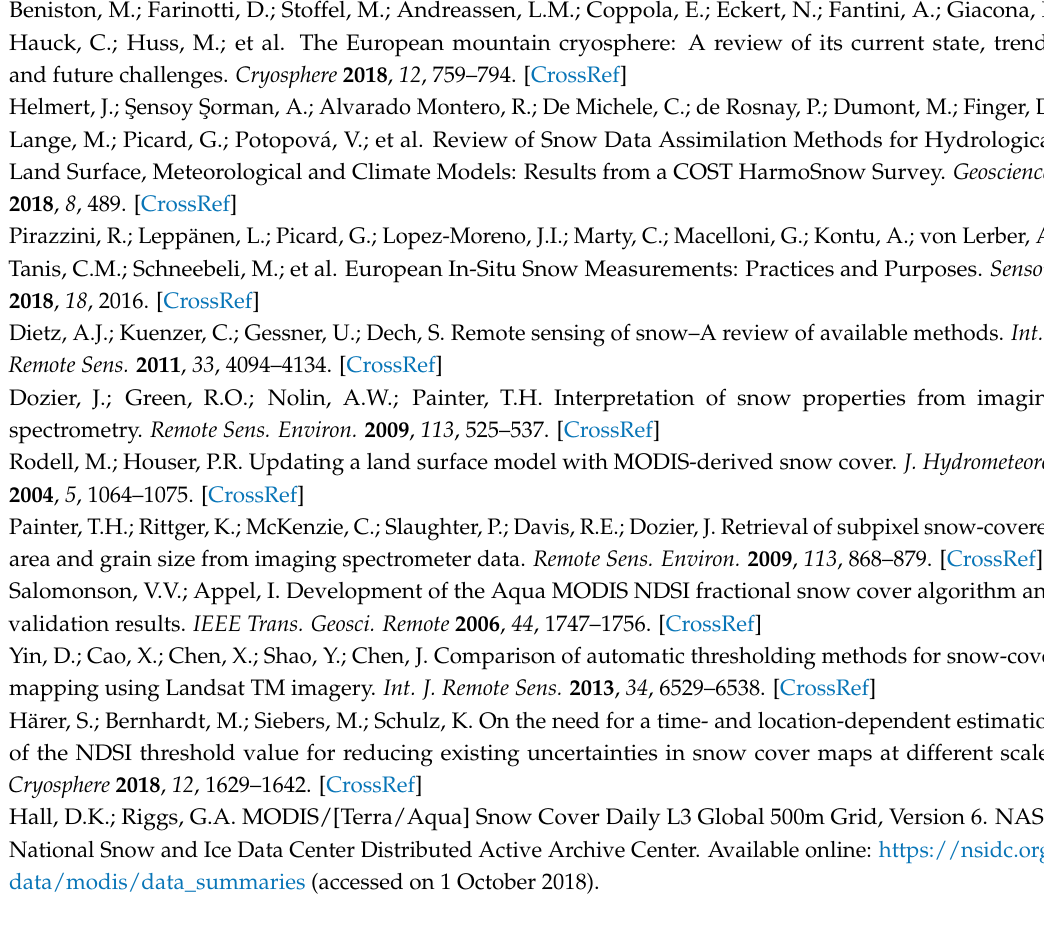
Figure S1: Example of comparison between output obtained by automated classifications on a terrestrial image, Table S1: Training dataset composed by FSC estimated using supervised and automated methods (Figure 4a), Table S2: Complete dataset composed by FSC estimated using only automated methods (Figure 4b), Table S3: Complete dataset composed by FSC estimated using satellite products (Figure